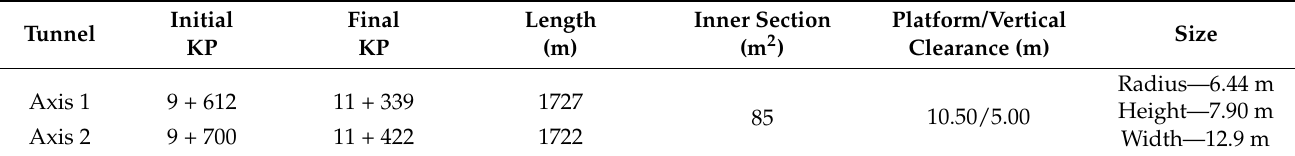
Figure 2. Functional section of the Arnotegi tunnel (5 m vertical clearance). Table 1. Main geometric characteristics of the Arnotegi